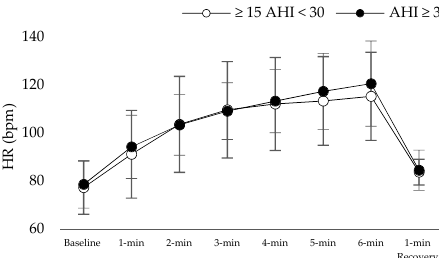
Figure 3. Oxidative stress marker on plasma antioxidant capacity (PAT) between groups.